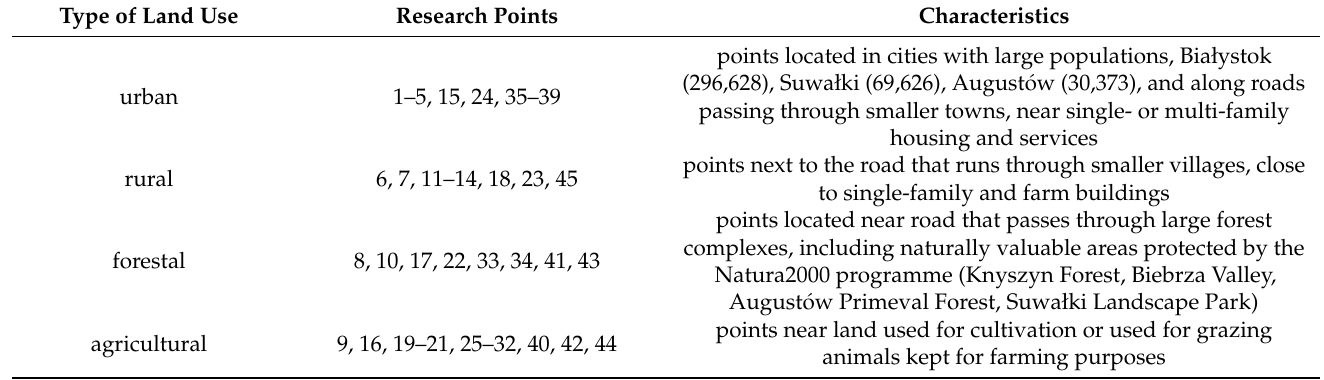
Table 1. General characteristics of the study area.